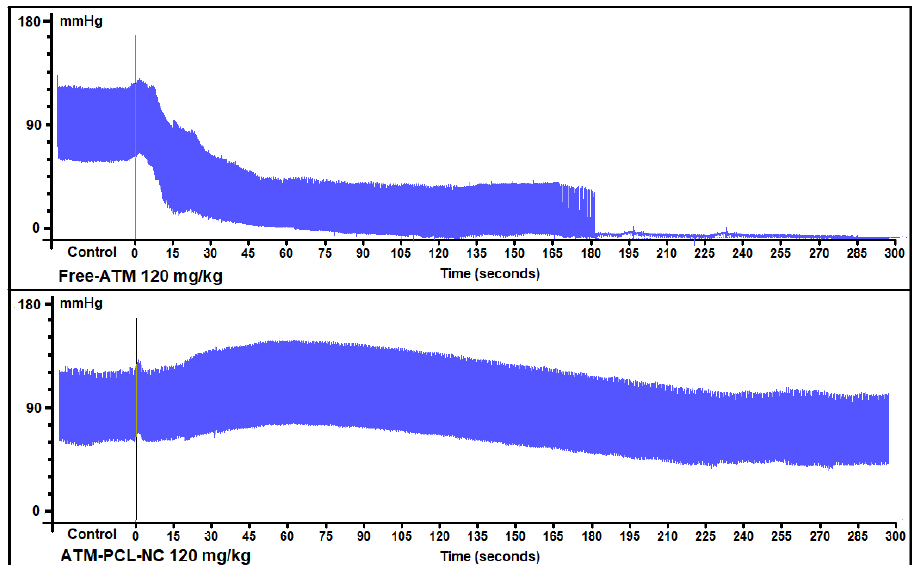
Figure 8. Representative signals of arterial blood pressure of anesthetized rats treated with free-ATM or ATM-PCL-NC, both at 120 mg/kg, showing the severe hypotension produced by the free form and the absence of hypotension with the NC formulation.